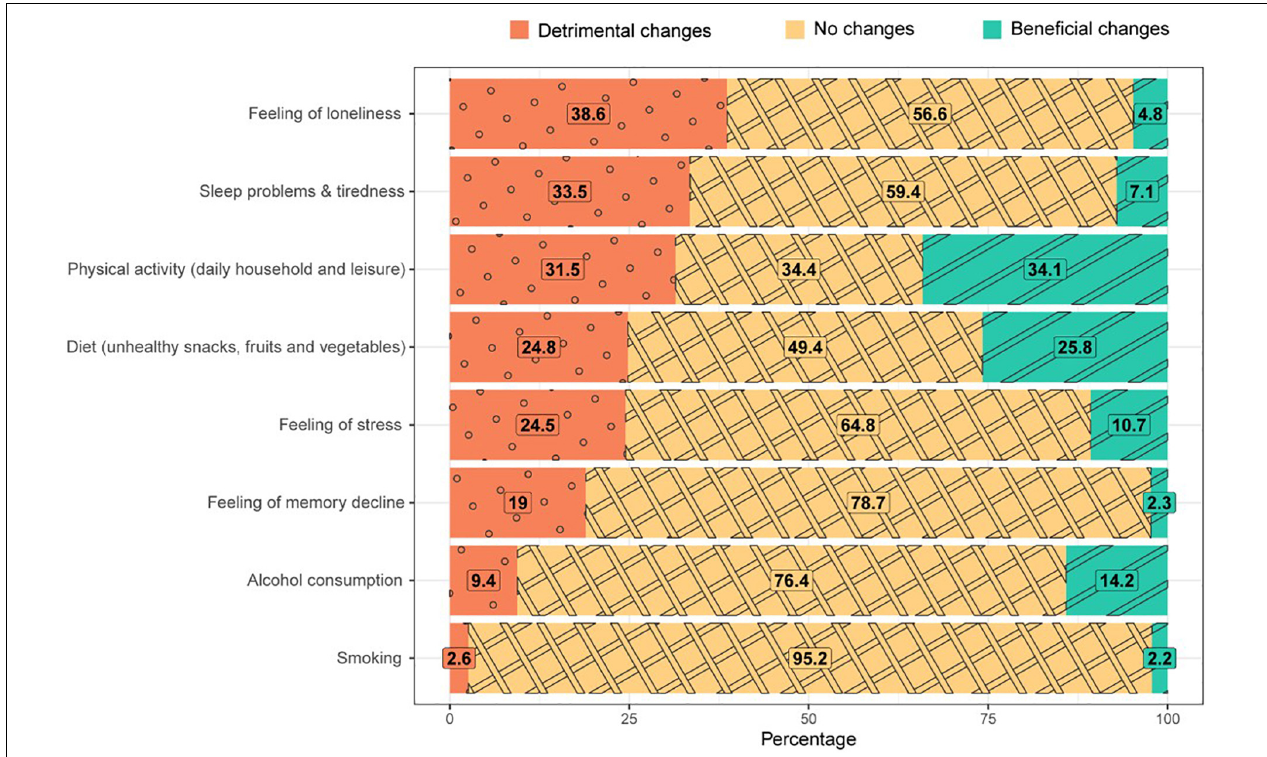
FIGURE 1 | Self-reported changes in percentages across eight modifiable factors related to brain health after one year of COVID-19 restrictions ( n = 3943).